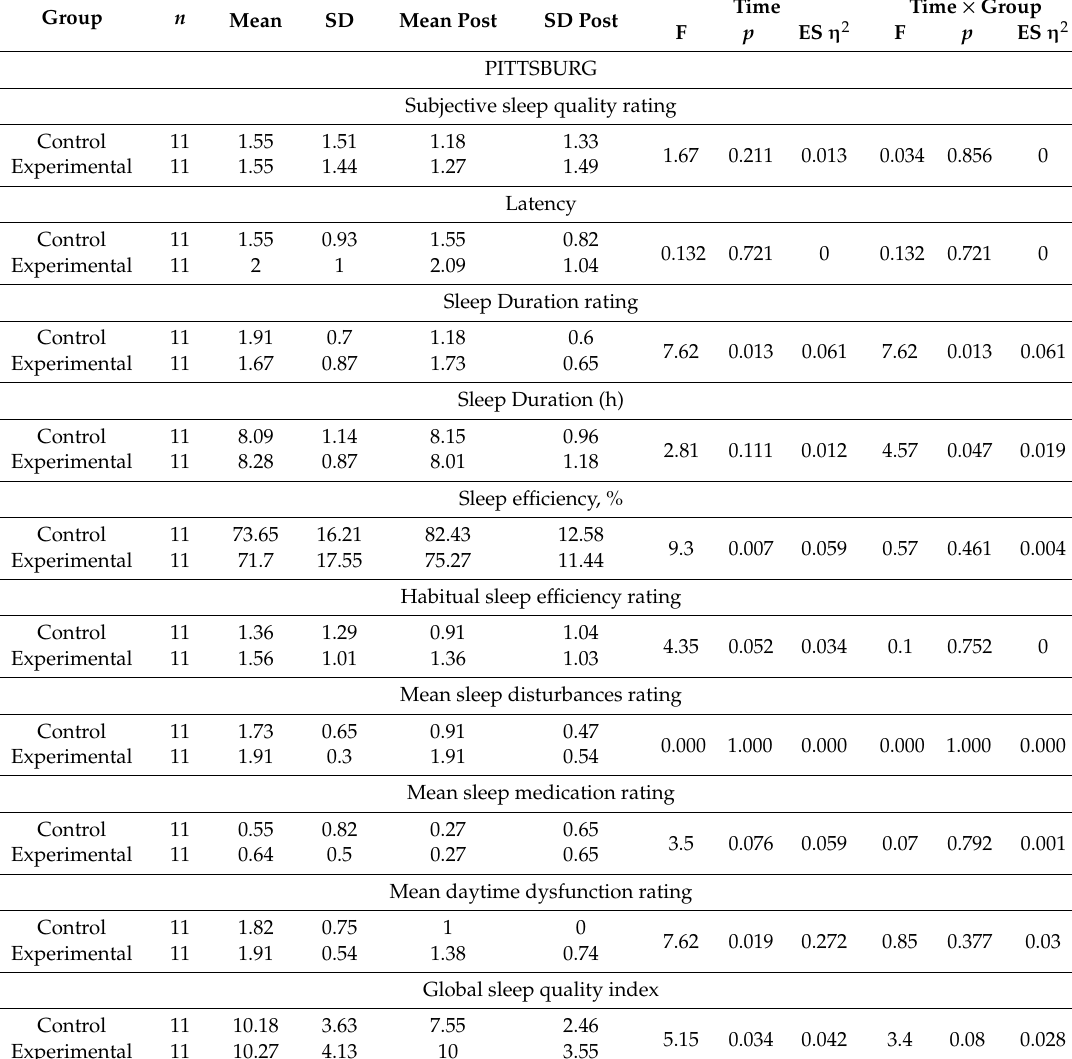
Table 1. E ff ects of tryptophan and magnesium-enriched Mediterranean diet on the Pittsburgh Sleep Quality Index (PSQI).